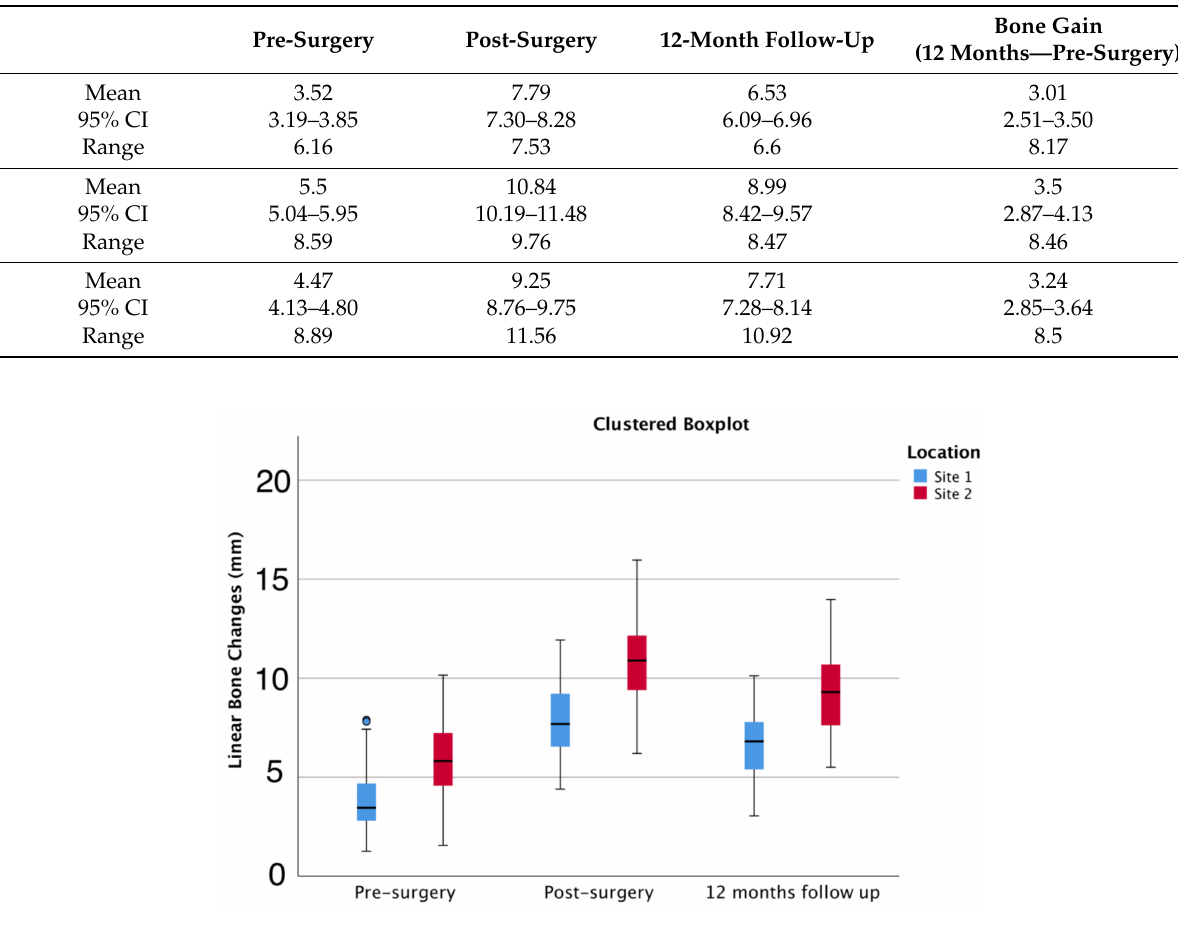
Figure 5. Linear bone changes (mm) (mean ± 95% CI) for different time points in 144 locations [ n = 18 patients]. p < 0.05 between locations and time